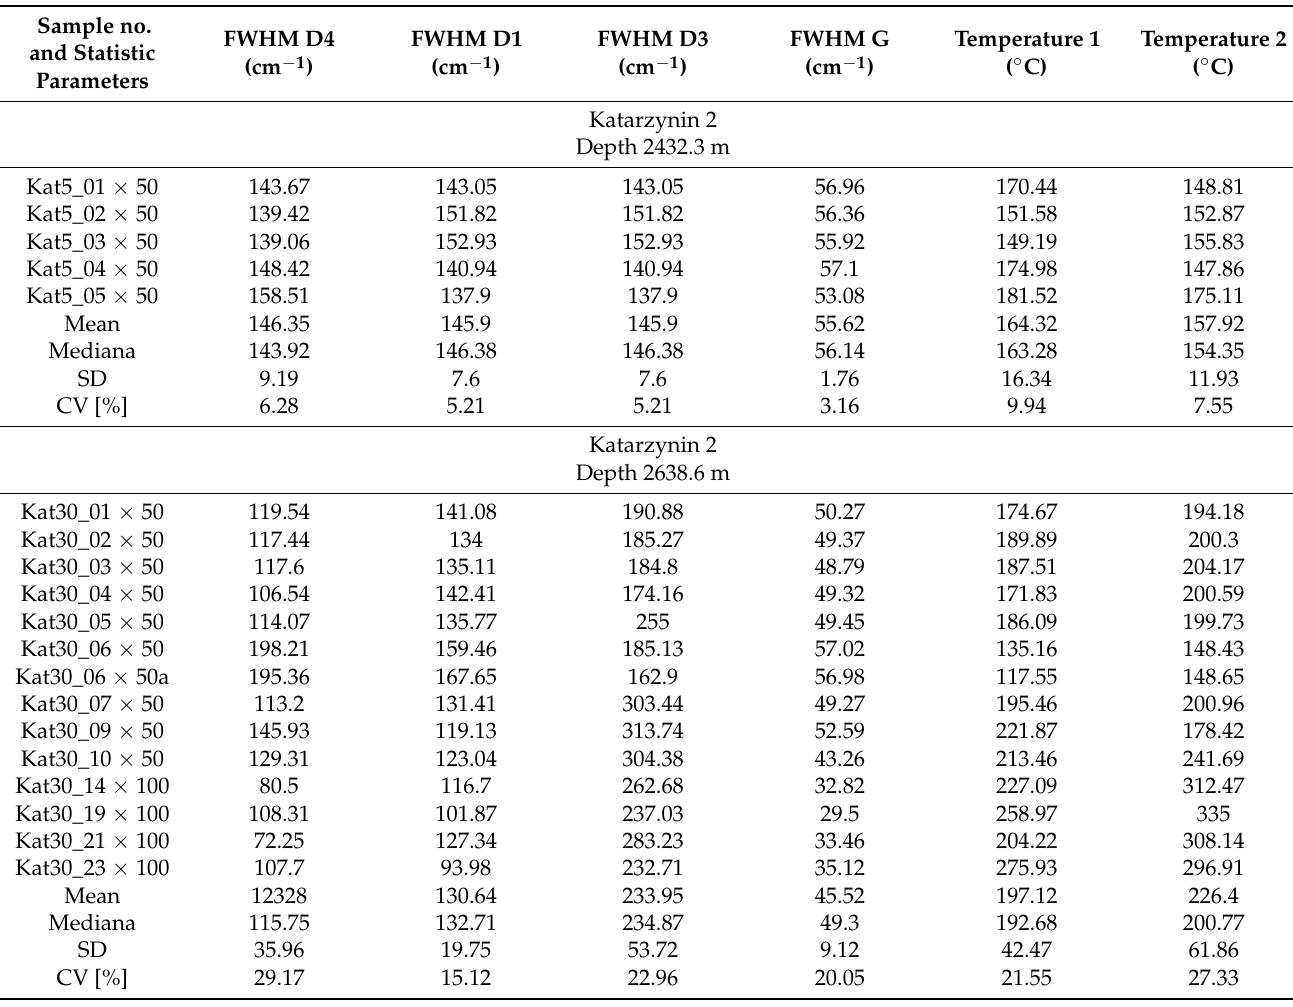
Table 7. Parameters of Raman spectra for organic matter